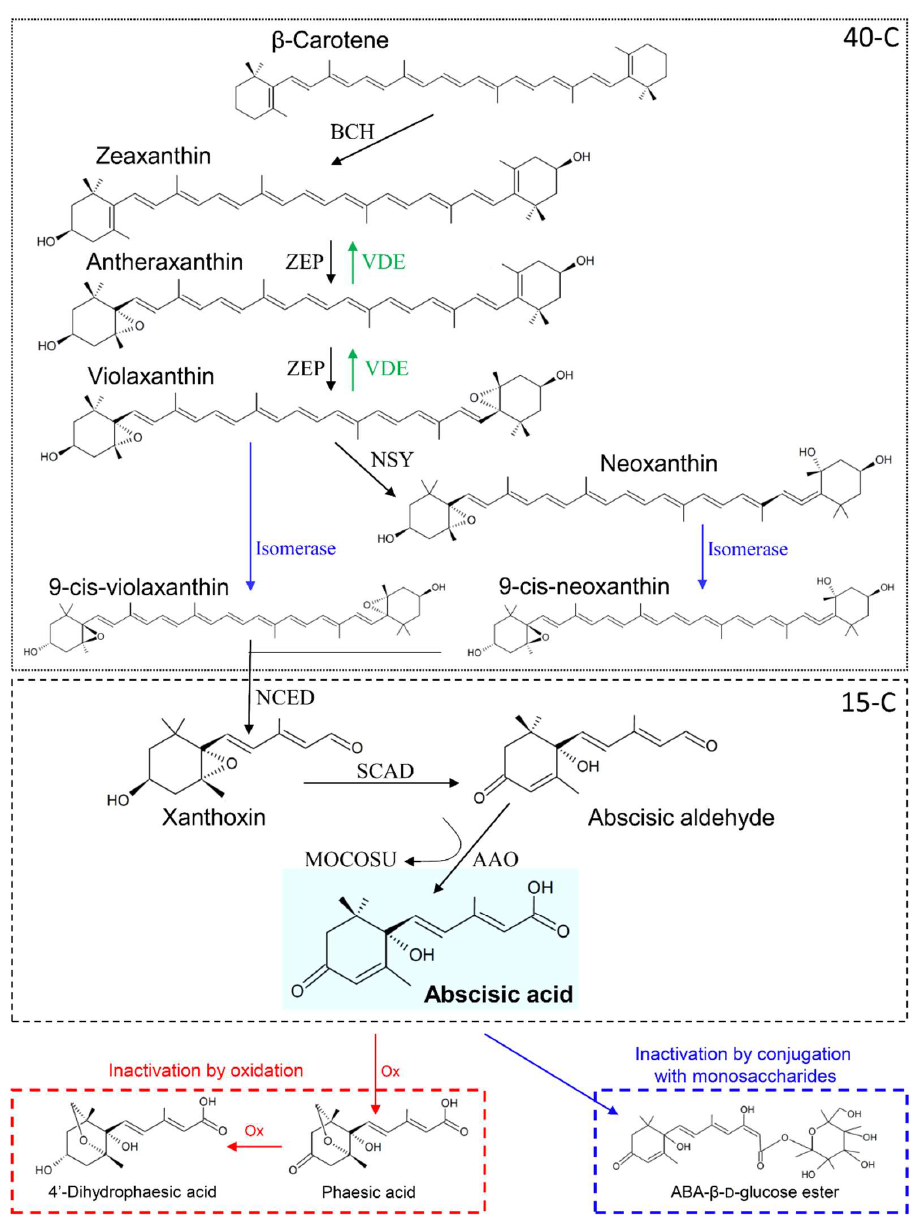
Figure 1. Abscisic acid biosynthesis and metabolism. In the first step, β-carotene is di-hydroxylated by β-carotene hydroxilase (BCH) proteins to produce the transisomer zeaxanthin. Hence, zeaxanthin is epoxidated by zeaxanthin oxidase (ZEP) to antheraxanthin and, then, to violaxanthin. ZEP-mediated reactions can be reversed by violaxanthin de-epoxidase (VDE). Violaxanthin can be transformed into neoxanthin by neoxanthin synthase (NSY) and both violaxanthin and neoxanthin are converted in the respective 9-cis-isomer by isomerase catalysts. The 15-carbons apocarotenoid sesquiterpenoid xanthoxin is then produced by cis-xanthophylls cleavage, whose reaction is catalyzed by 9-cis-epoxycarotenoid dioxygenase (NCED). Subsequently, xanthoxin is oxidized to abscisic aldehyde by short-chain alcohol dehydrogenase (SCAD), and finally abscisic acid (ABA) is produced by oxidation of abscisic aldehyde through the combined action of ABA-aldehyde oxidase (AAO) and a molybdenum cofactor sulfurase (MOCOSU). ABA can be inactivated by oxidation or by conjugation with monosaccharides. In the first way, ABA is oxidized (Ox) at first to phaseic acid and then to 4′-dihydrophaseic acid. In the second one, ABA is conjugated with glucose to produce ABA-β-D-glucose ester. Based on [9].